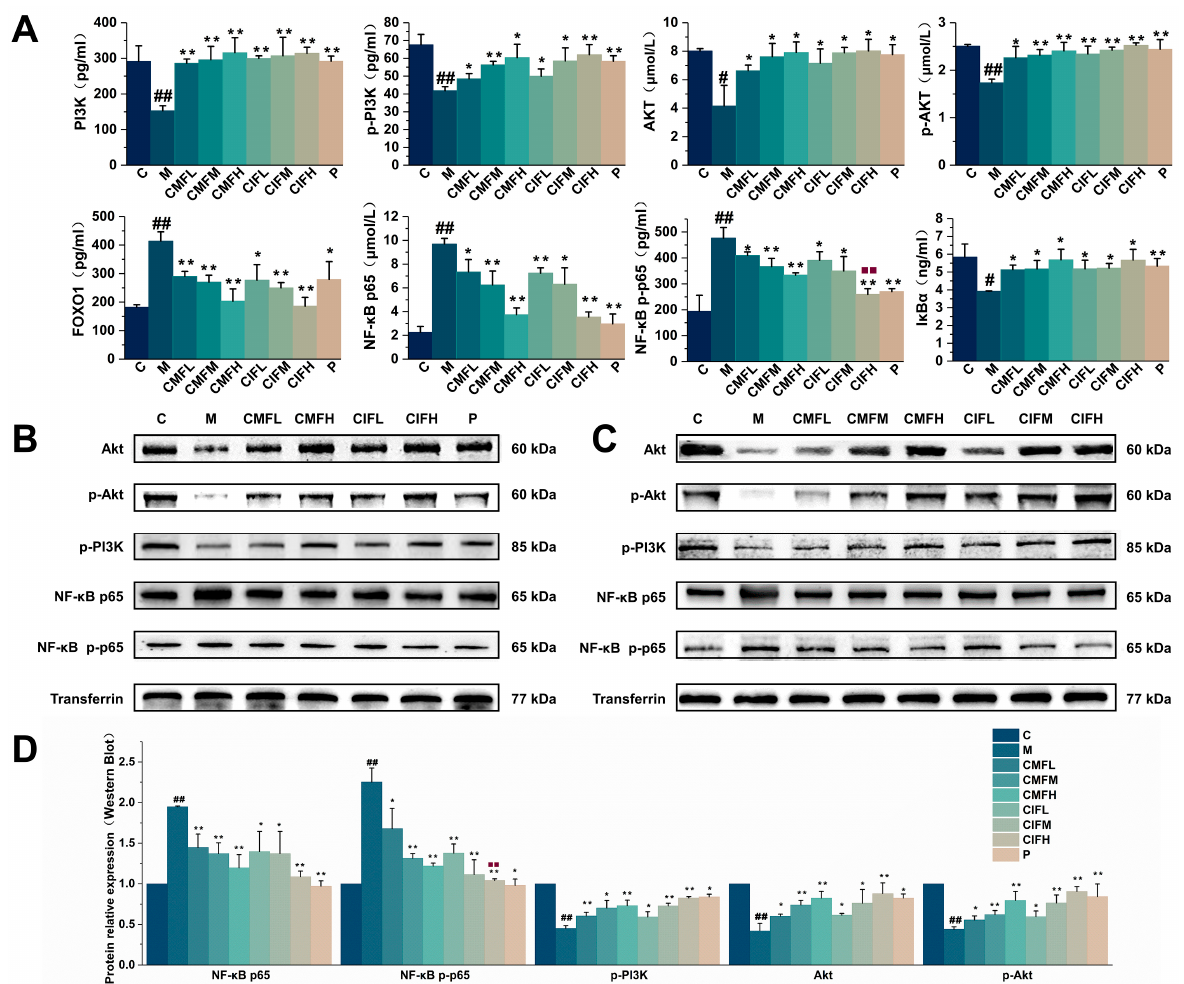
Figure 7. Analysis of the key proteins of NF- κ B and PI3K-Akt signaling pathways. ( A )—ELISA analysis of PI3K, p-PI3K, Akt, p-Akt, FOXO1, NF- κ B p65, NF- κ B p-p65, I κ B α , respectively; ( B )—Typical bands for Western blot analysis of Akt, p-Akt, p-PI3K, NF- κ B p65, and NF- κ B p-p65 in C, M, CMFL, CMFH, CIFL, CIFH, P groups; ( C )—Typical bands for Western blot analysis of Akt, p-Akt, p-PI3K, NF- κ B p65, and NF- κ B p-p65 in C, M, CMFL, CMFM, CMFH, CIFL, CIFM, CIFH groups; ( D )—The relative expression of proteins in Western blot analysis. Values shown are means ± SD. # p < 0.05, ## p < 0.01 compared with C group; * p < 0.05, ** p < 0.01 compared with M group; ■■ p < 0.01 compared with CMFH group.